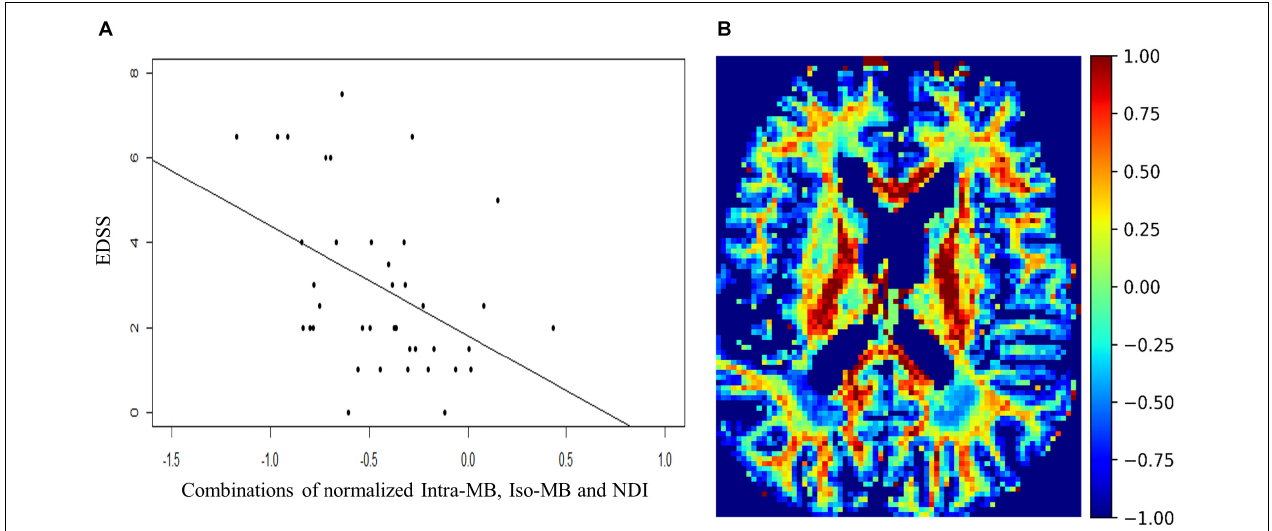
FIGURE 4 | (A) Scatter plot and a regression line of EDSS and the combinations of normalized Intra-MB, Iso-MB, and NDI, which has strongest correlation. (B) An exemplary image of the combined contrast.